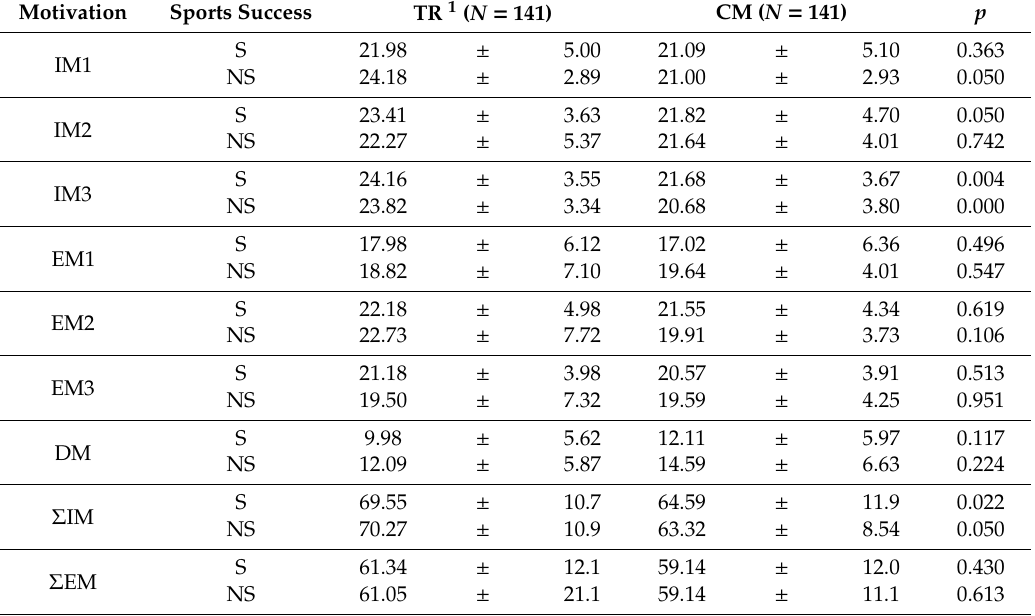
Table 2. Mean and standard deviation were calculated in baseline and precompetitive contexts with the motivation dimensions according to the sports success.